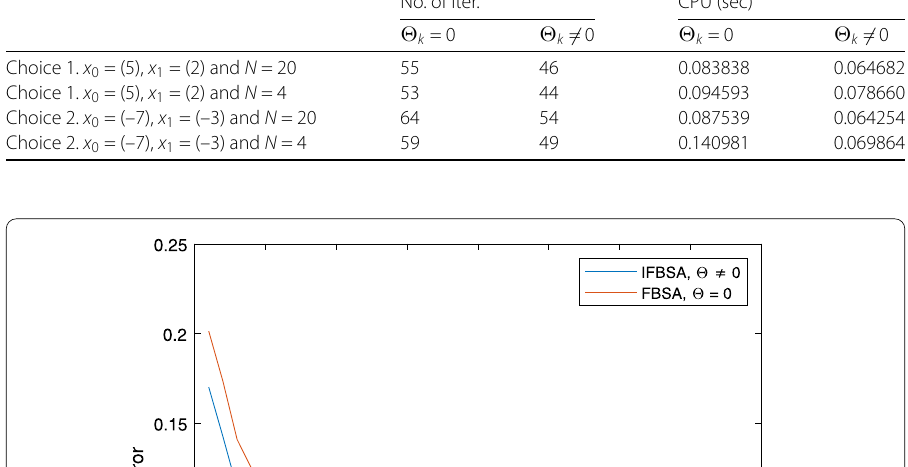
No. of iter. CPU (sec) (cid:12) k = 0 (cid:12) k (cid:10) = 0 (cid:12) k = 0 (cid:12) k (cid:10) = 0